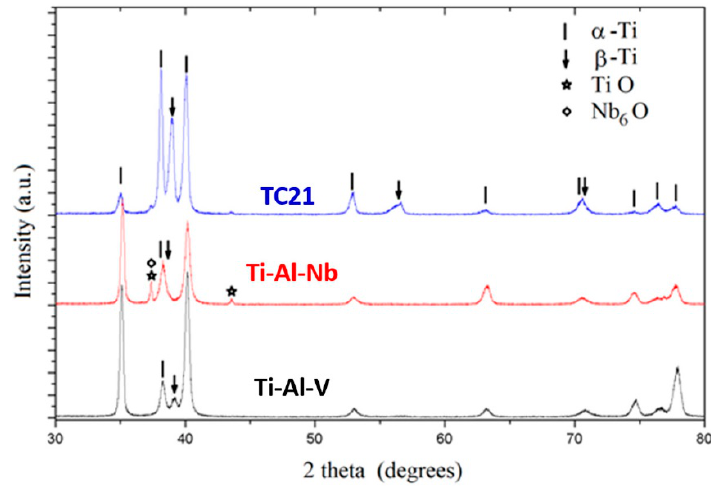
Figure 3. XRD diffraction patterns recorded for the Ti-6Al-4V, Ti-6Al-7Nb and TC21